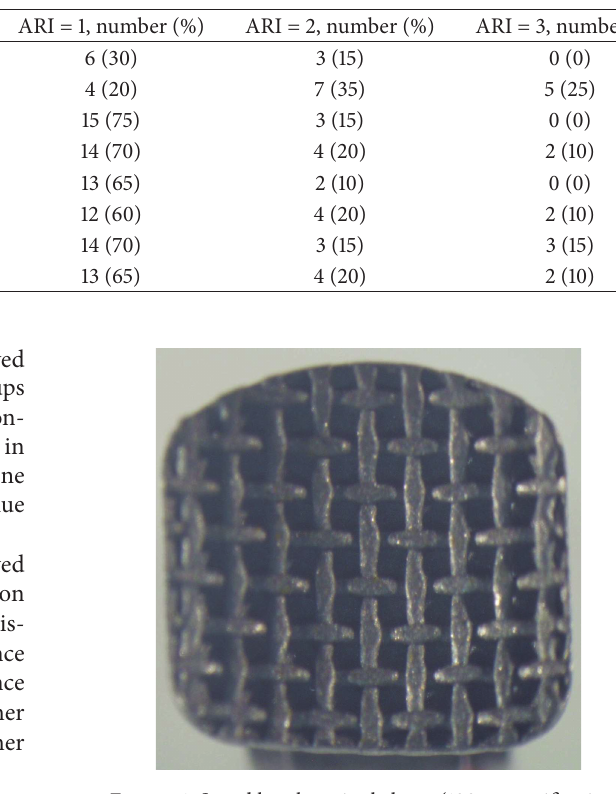
Figure 1: Speed bracket, single layer (100x magnification).